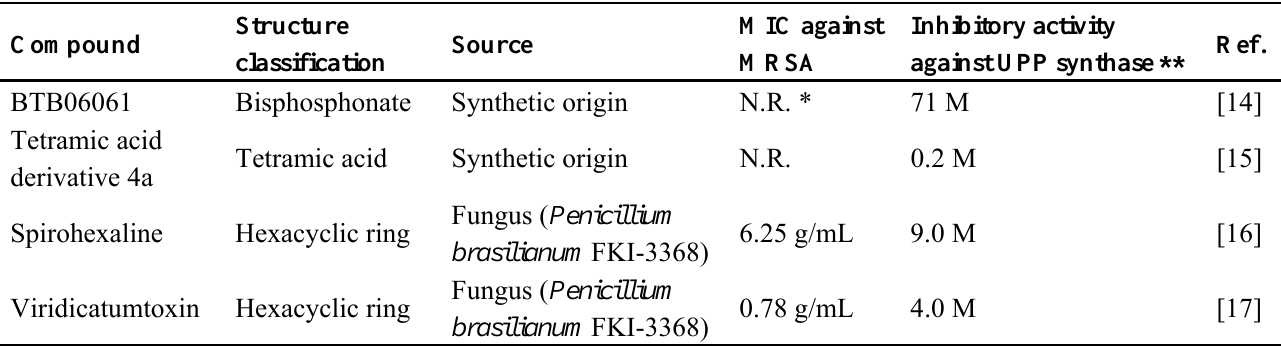
Table 1. UPP synthase